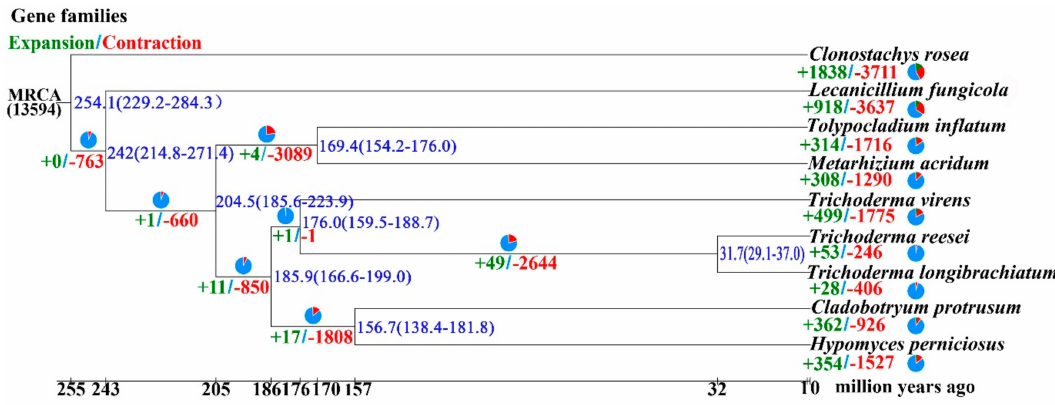
Figure 2. The H. perniciosus genome phylogeny and analysis of contraction and expansion gene families analysis among nine fungal species. The divergence time range (blue), the number of expanded (green) and contracted (red) gene families is shown at each branch. The estimated divergence time (MYA: million years ago) is shown at the bottom. MRCA: most recent common